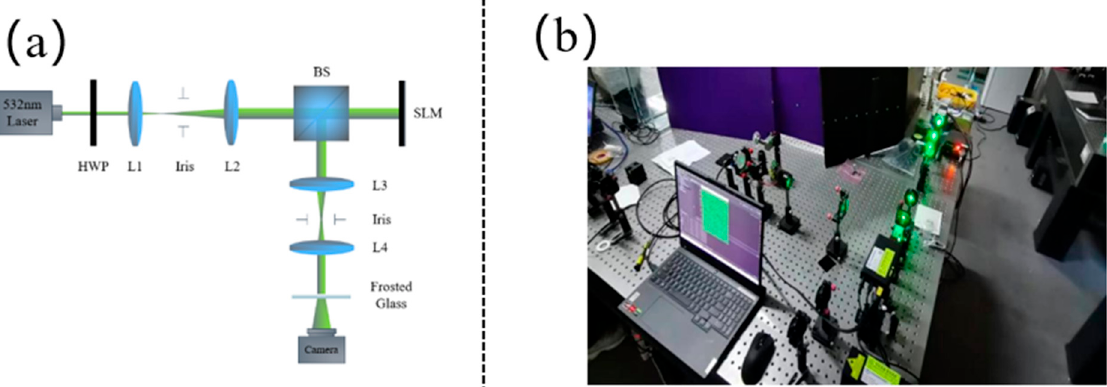
Figure 6. Experimental optical path design: ( a ) simulated optical path design and ( b ) actual data- acquisition optical path.